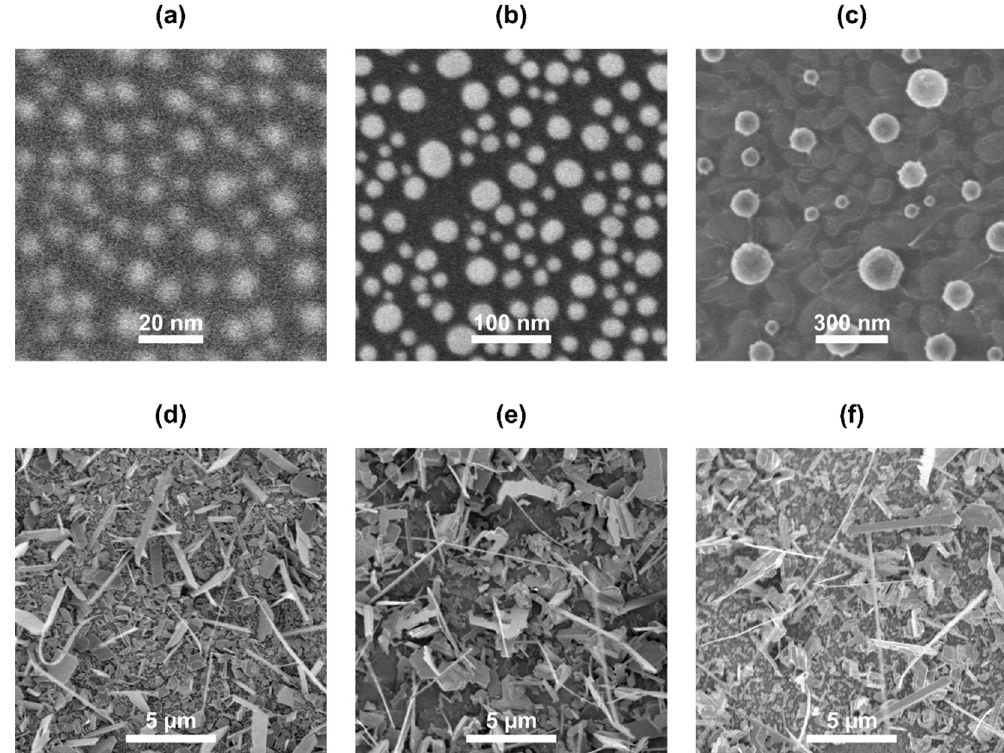
Figure 1. SEM images: ( a – c ) Thermally dewetted Au layers with various initial layer thicknesses: ( a ) 3 nm; ( b ) 9 nm; ( c ) 13 nm; ( d – f ) Bi 2 Se 3 nanostructures synthesized on dewetted Au layers with various initial layer thicknesses: ( d ) 3 nm; ( e ) 9 nm; ( f ) 13 nm.